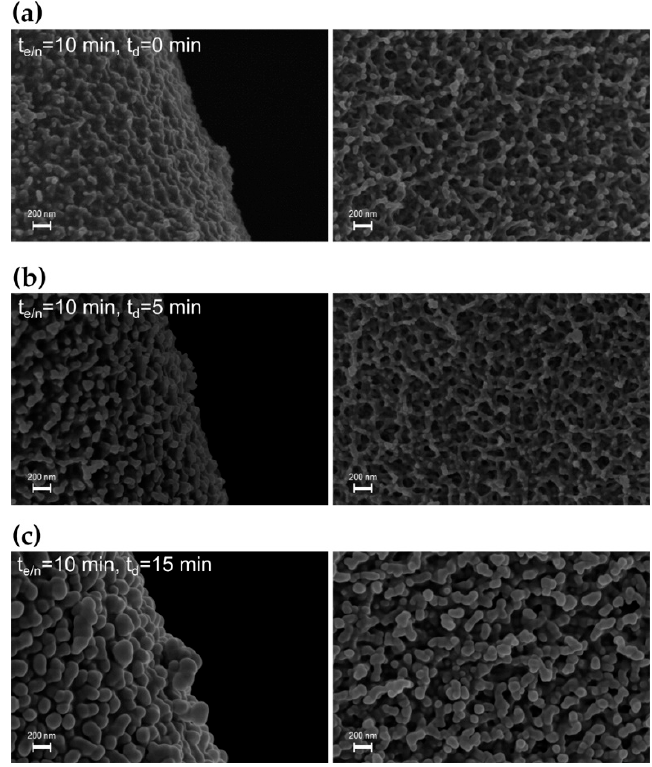
Figure 5. SEM images of the PU foams treated by the two-step plasma process, keeping fixed at 10 min the duration of step 1 and varying the duration of step 2: t d of 0 min ( a ), 5 min ( b ), 15 min ( c